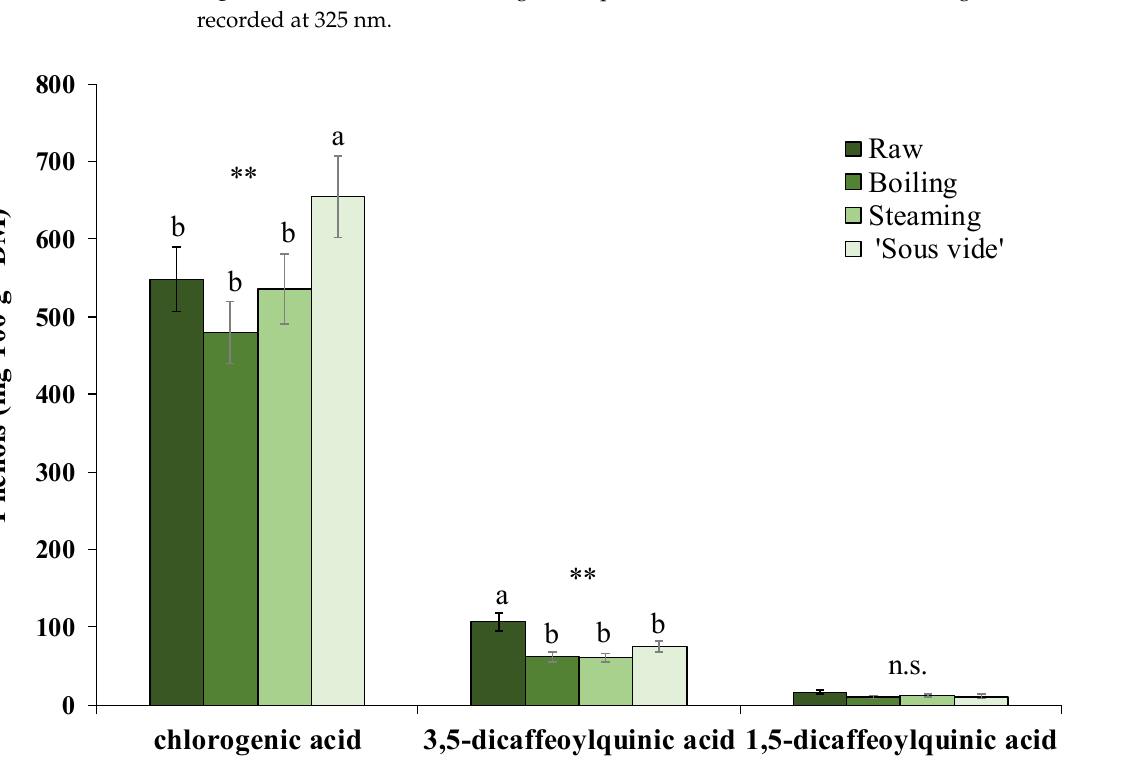
Figure 4. Main phenolic compounds identified in golden thistle midribs raw and cooked by boiling, steaming, and ‘sous vide’. Vertical bars indicate the standard deviation. Different letters indi- cate statistically different values ( α = 0.05) between treatments. Significance: n.s., not significant; **, significant at p ≤